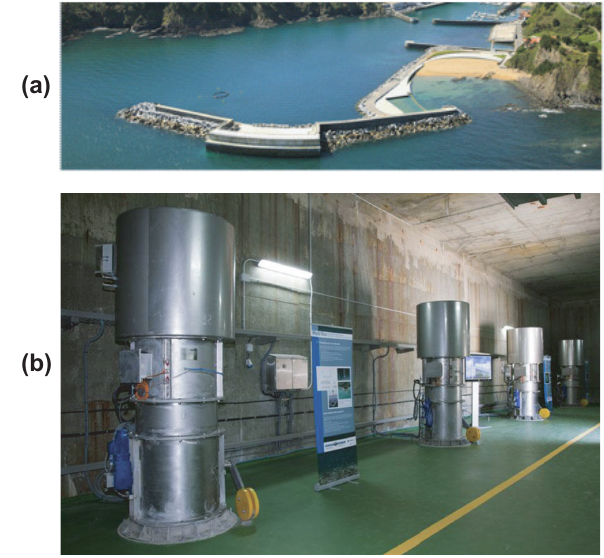
Figure 1. NEREIDA wave power plant in Mutriku, Spain: ( a ) the plant and the breakwater; ( b ) PTO of OWC units inside the